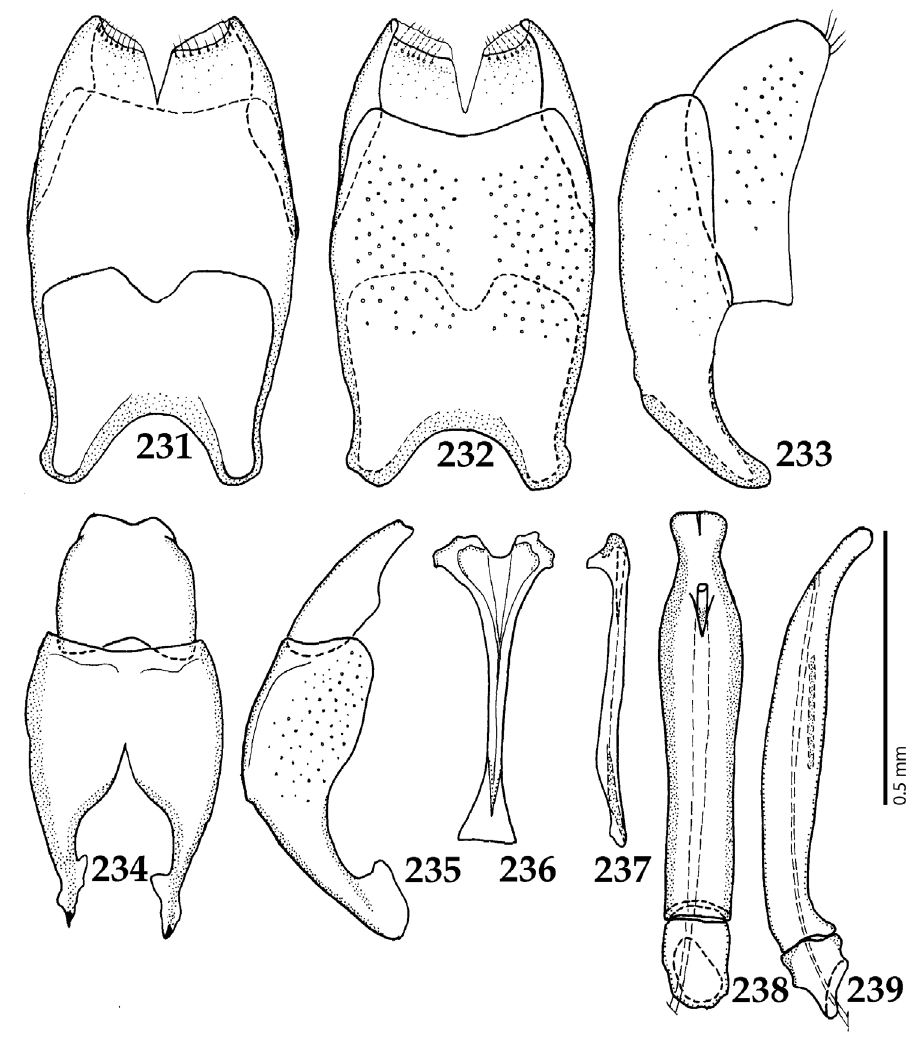
Figures 231–239. 231 Notosaprinus irinus (Marseul, 1862) male terminalia: 8 th sternite + 8 th tergite, ventral view 232 ditto, dorsal view 233 ditto, lateral view 234 male terminalia: 9 th + 10 th tergites, dorsal view 235 ditto, lateral view 236 male terminalia: spiculum gastrale, ventral view 237 ditto, lateral view 238 aedeagus, dorsal view 239 ditto, lateral